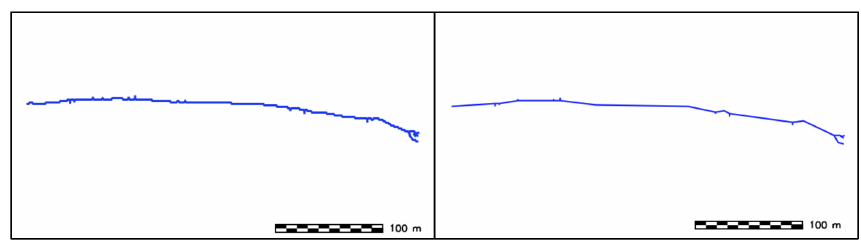
Figure 12. SWC topological cleaning.